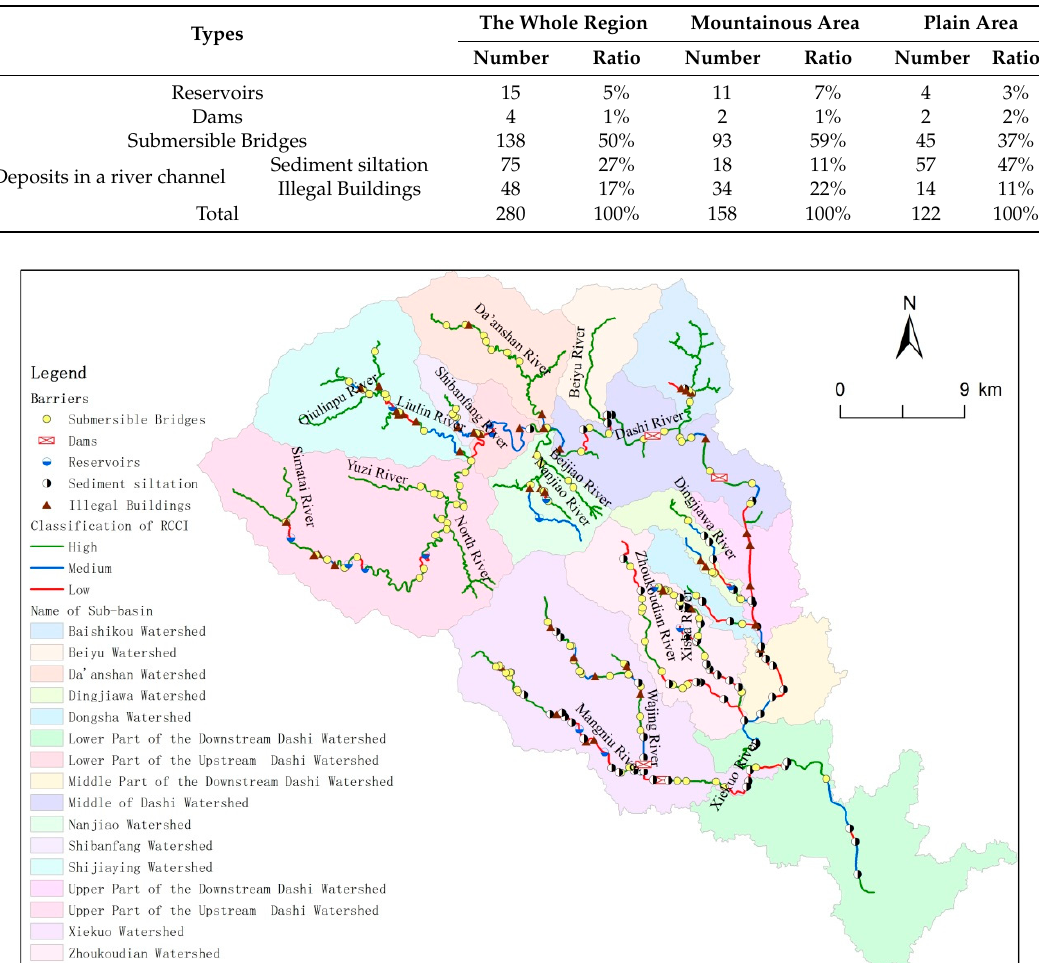
Table 3. Number and ratio of various types of barriers in Dashi Watershed.